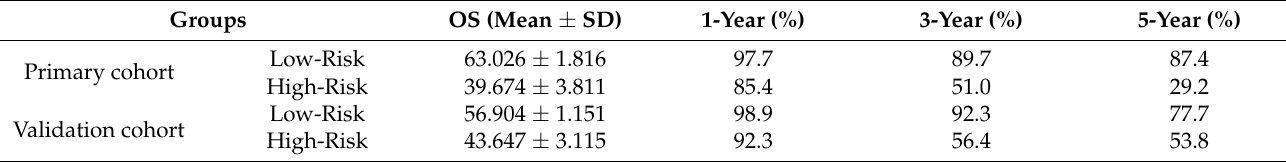
Table 4. Overall survival time (OS) in the primary cohort and validation